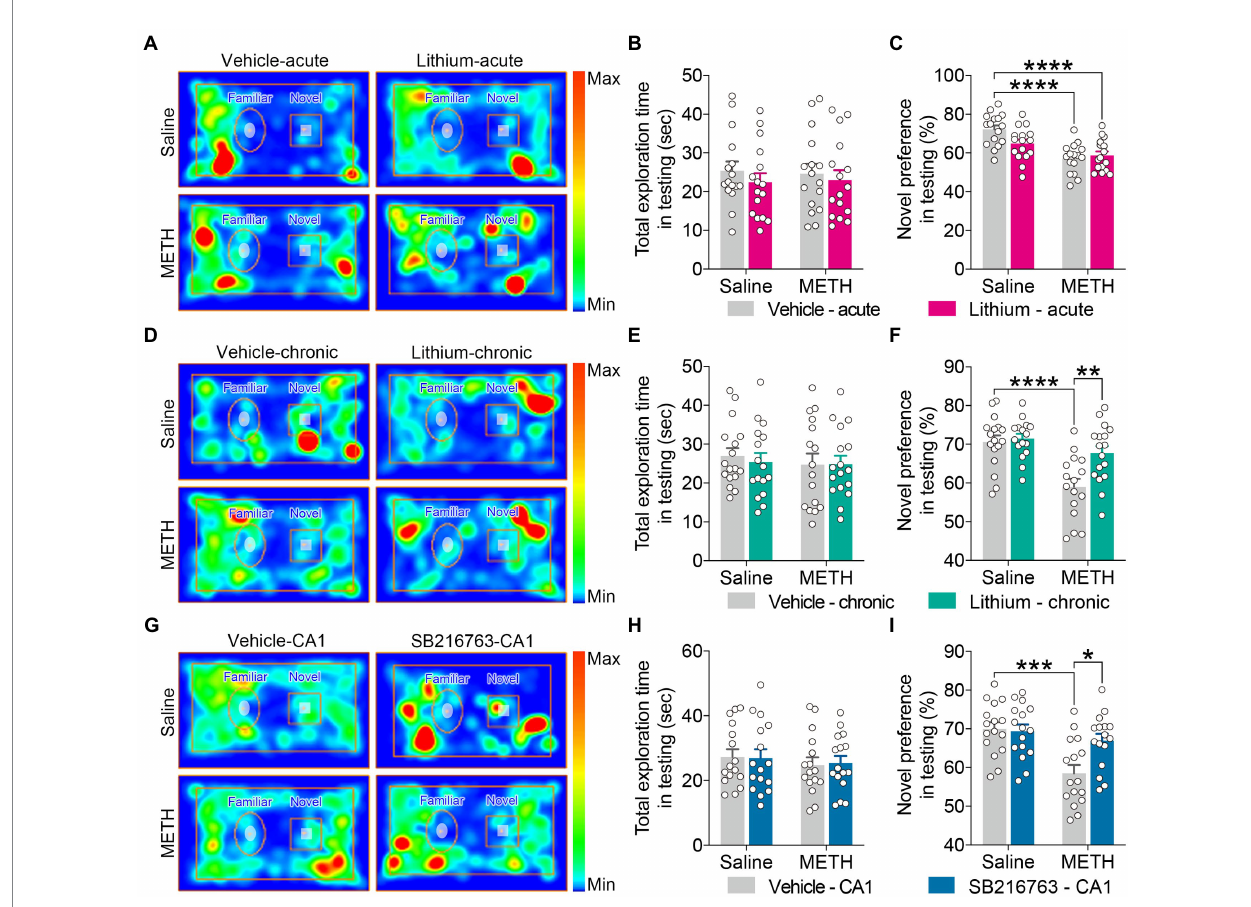
FIGURE 5 Effect of GSK3 β inhibition on adolescent METH exposure-induced object recognition memory impairment in adulthood. Compared with the effect of the acute systemic intervention (A–C) , chronic systemic intervention (D–F) and chronic intervention within CA1 (G–I) improved adolescent METH exposure-induced object recognition memory impairment in adulthood. Representative heat maps show the location of the mice during the testing phase (A,D,G) . Histograms show the total exploration time (B,E,H) and novel preference (%) (C,F,I) during the testing phase. Data are presented as the mean +/ − SEM, each symbol represents the independent of a single animal; two-way ANOVA followed by the Bonferroni post hoc test; n = 16 ~ 17/ group; * p < 0.05, ** p < 0.01, *** p < 0.001, and **** p < 0.0001, comparison between the two indicated groups. See also Supplementary Figure